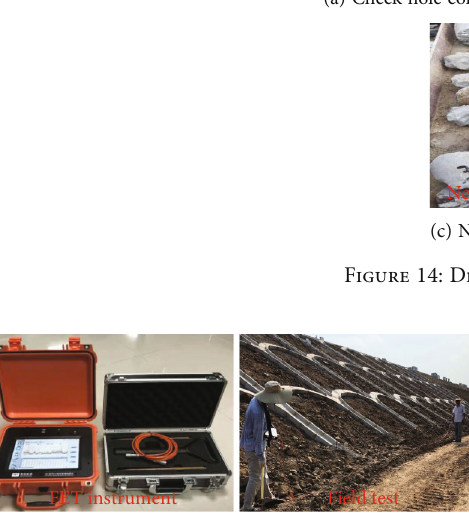
Figure 15: FET audiofrequency magnetotelluric instrument and fi eld